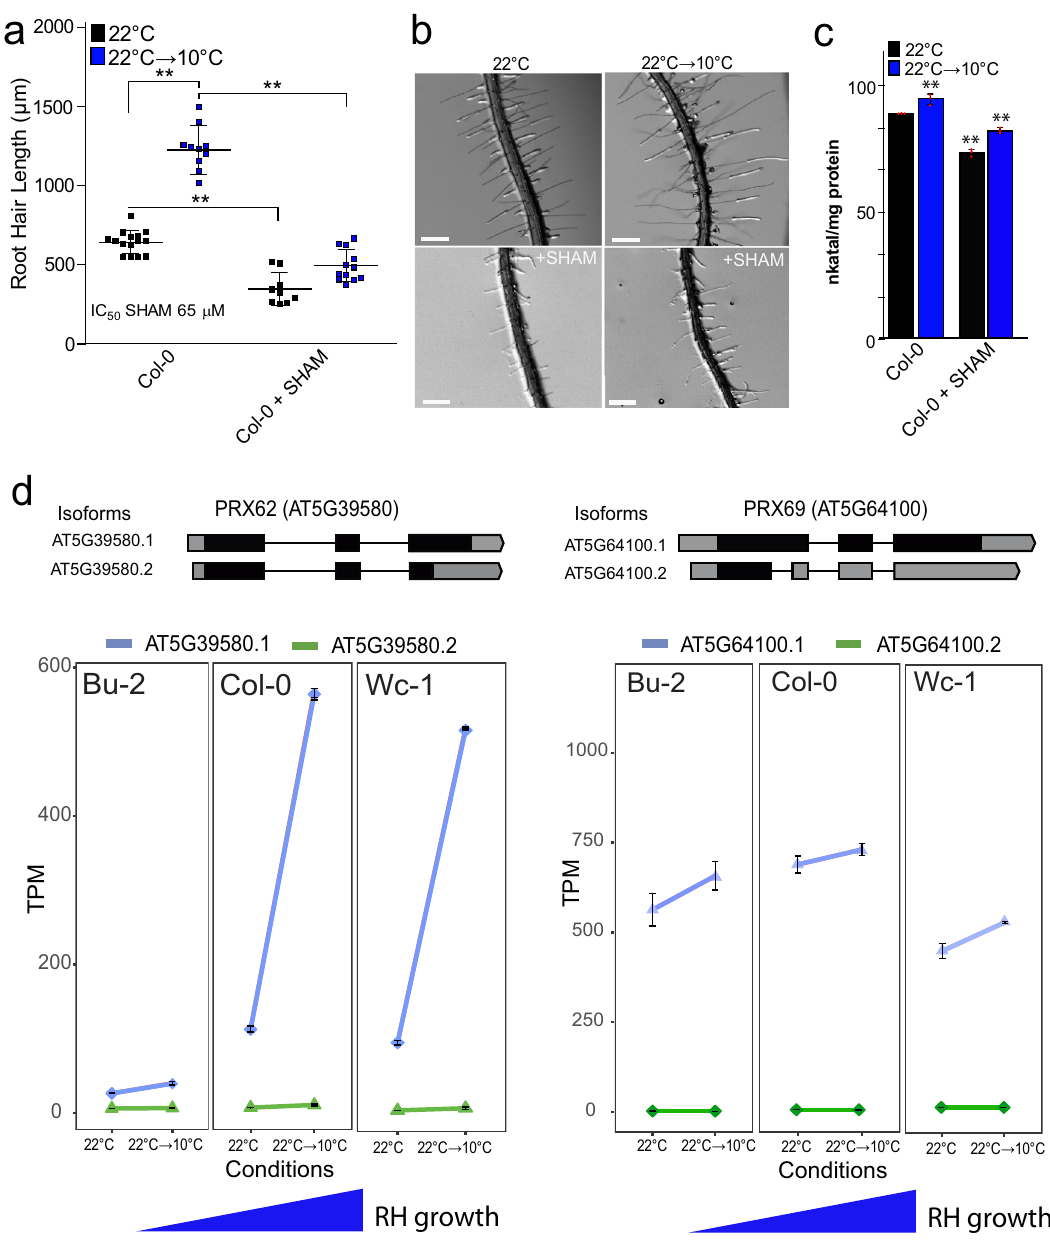
Fig. 2 Low temperature enhanced RH growth requires peroxidase activity and upregulates PEROXIDASE 62 (PRX62) expression. a RH length phenotype of Col-0 with or without the addition of the PRX inhibitor SHAM. Inhibitory Concentration 50 (IC 50 ) of RH grown at 22 °C was used (65 µ M). Each point is the mean of the length of the 10 longest RHs identi fi ed in a single root. Data are the mean ± SD ( N = 16 roots), two-way ANOVA followed by a Tukey – Kramer test; (**) p < 0.01. Results are representative of three independent experiments. Asterisks indicate signi fi cant differences between Col-0 and the corresponding genotype at the same temperature. Exact p-values are provided in the Source Data fi le. b Representative images of RH phenotype of Col- 0 quanti fi ed in ( a ). Scale bars 500 µ m. c Total root peroxidase activity. Peroxidase activity was assayed using guaiacol/hydrogen peroxide as substrate in root tissues grown with or without 65 µ M SHAM, either for 5 days at 22 °C or for 5 days at 22 °C plus 3 days at 10 °C. Enzyme activity values (expressed as nkatal/mg protein) are the mean of three biological replicates ± SD. p -value of two-way ANNOVA followed by a Tukey – Kramer test (**) p < 0.01. Exact p-values are provided in the Source Data fi le. d In contrast to PRX69 , PRX62 is differentially expressed at low temperature (10 °C) in Arabidopsis accessions with contrasting RH phenotypes. Expression measured by RNA-seq of PRX62 and PRX69 in three contrasting Arabidopsis accessions based on the RH phenotype (short RH in Bu-2 and extra-long RH in Col-0 and Wc-1) detected at 10 °C. Isoforms ’ schemes were adapted from boxify (https:// boxify.boku.ac.at/). TPM = Transcripts Per Kilobase